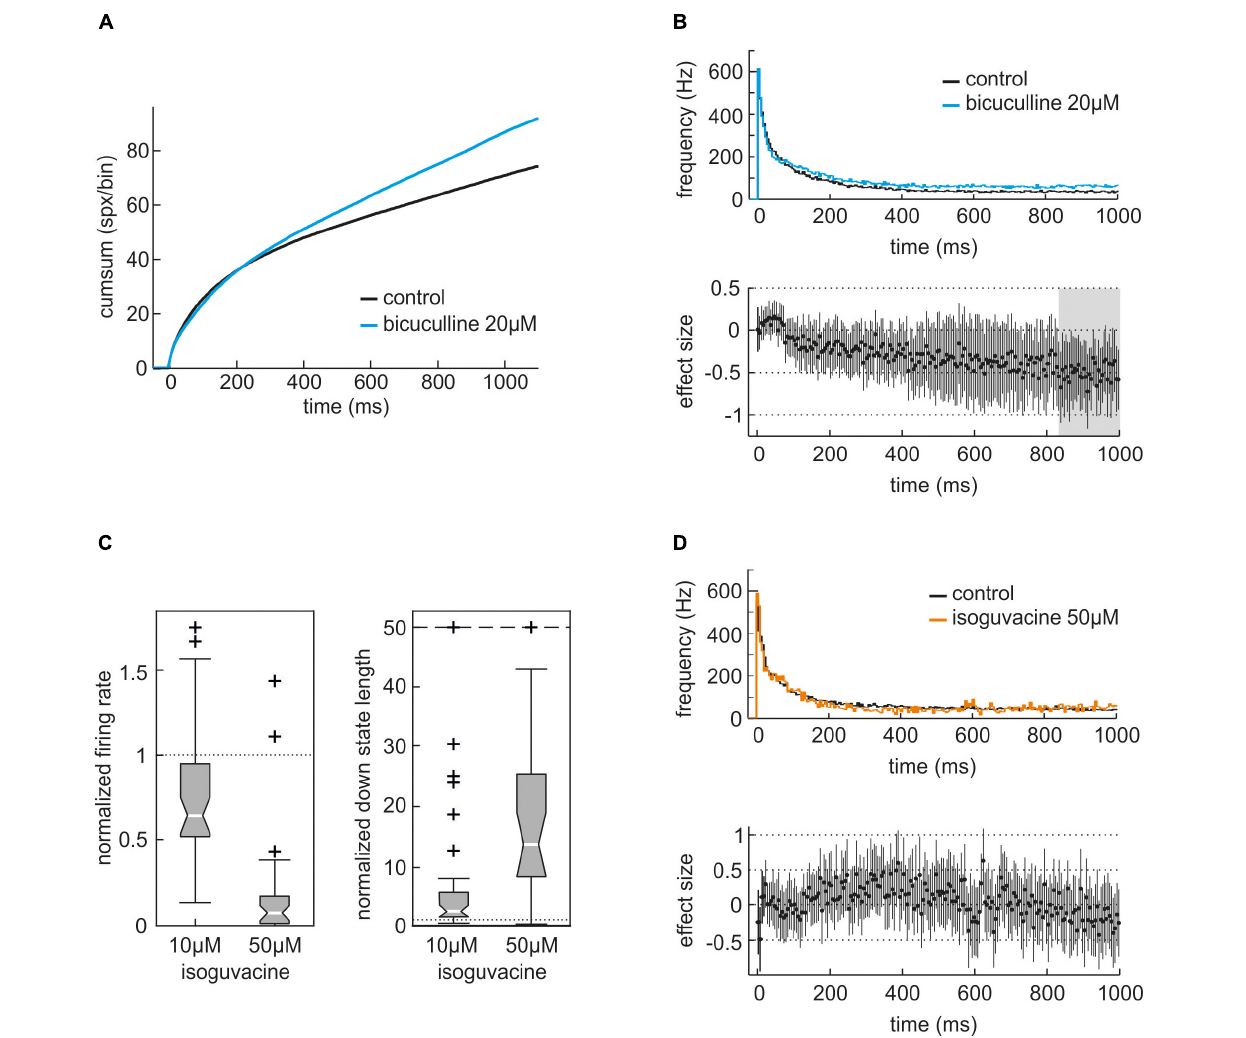
FIGURE 2 | Actions of the GABA A receptor antagonist bicuculline and the GABA A receptor agonist isoguvacine on neuronal activity of neocortical slice cultures. (A) Cumulative sum of action potentials during the first 1000 ms of the averaged up state in the absence (control, black) and presence of 20 µ M bicuculline (blue, n = 32). (B) Peri-event time histogram (PETH) of averaged neuronal up states in the absence (black) and presence of bicuculline (blue). For the analysis of actions of GABAergic modulators on neuronal activity we collected all up states, averaged and divided these into time bins of 5 ms. Then, we calculated the instantaneous frequency of action potential firing for each 5-ms time bin and plotted them against the time. In the presence of 20 µ M bicuculline, activity is almost constantly higher compared to control condition. Lower part of the figure: effect size. An effect size of one would indicate that the neuronal activity is one standard deviation apart. A significant difference between the two conditions can be assumed if the 95% confidence interval (CI) does not cross the zero line. Here, the effect of bicuculline is slightly building up and most prominent after 800 ms from the beginning of the up state, marked by gray shadowing. (C) Actions of 10 and 50 µ M isoguvacine on the normalized firing rate and the normalized length of down states given as boxplot. Isoguvacine depressed the averaged action potential firing rate to 0.64 (median, iqr = 0.42, n = 40, p = 0.00012, Mann–Whitney U -test compared to control condition) at 10 µ M and to 0.07 (median, iqr = 0.16, n = 25, p < 0.0001) at 50 µ M. Meanwhile, the averaged length of neuronal down states was prolonged by 10 µ M isoguvacine to 2.59 (median, iqr = 4.03, n = 40, p < 0.0001) and to 13.66 (median, iqr = 17.1, n = 25, p = 0.000012) at a concentration of 50 µ M. (D) Analysis of the actions of 50 µ M isoguvacine within neuronal up states given as PETH plus corresponding effect size. The PETH of control (black) and 50 µ M isoguvacine (orange) are virtually superimposable while the corresponding effect size swings round the zero line, indicating that isoguvacine does not primarily affect neuronal up states. Taken together this illustrates that isoguvacine is depressing neuronal activity in neocortical cultures from mice by prolonging neuronal down states while activity within up states is almost unaffected.